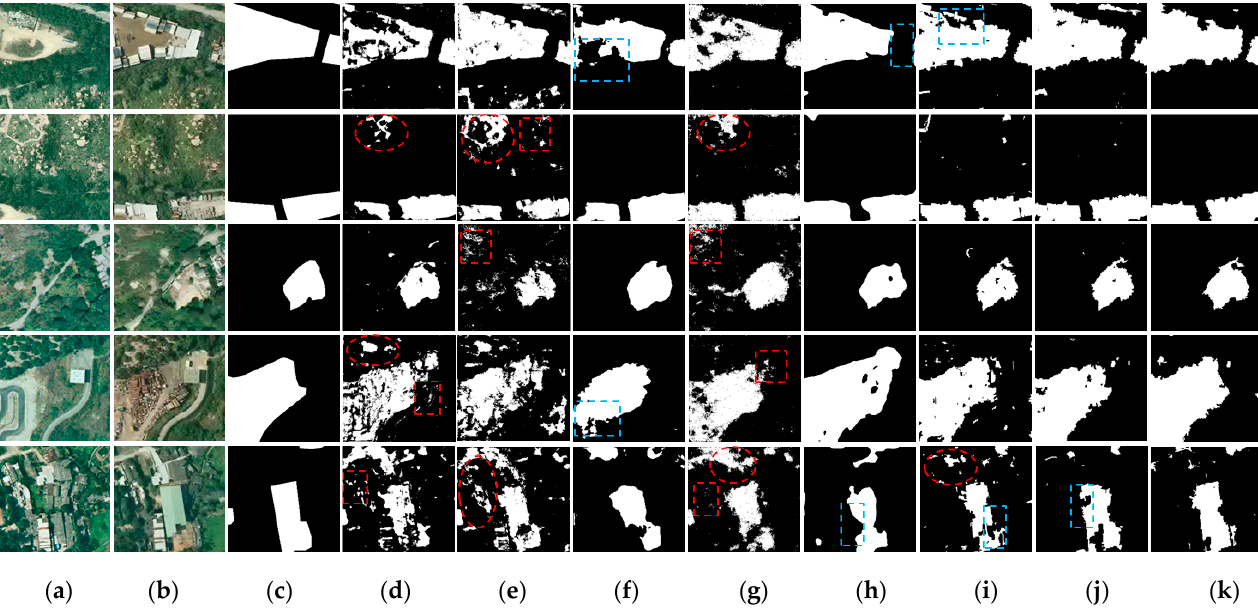
Figure 10. Some typical CD maps by different methods on the SYSU-CD data set. ( a ) Image T1. ( b ) Images T2. ( c ) Reference change map. ( d ) FC-Siam-con. ( e ) FC-Siam-diff. ( f ) Siam-NestedUNet. ( g ) DSFIN. ( h ) DSAMNet. ( i ) GCNCD. ( j ) MSGCN. ( k ) DNHGNN.